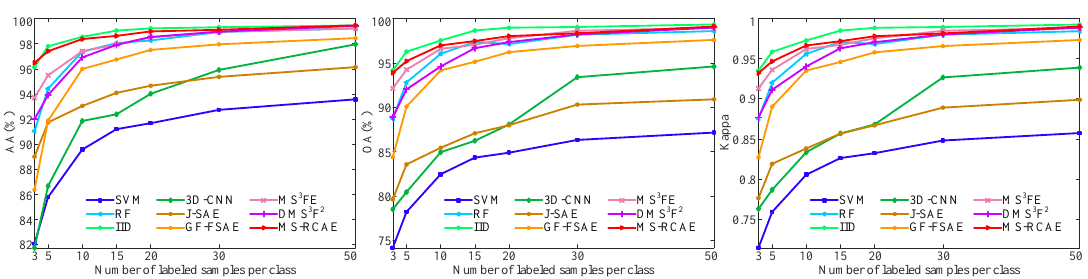
Figure 13. Effect of the number of training samples on classification accuracy for the University of Pavia dataset.